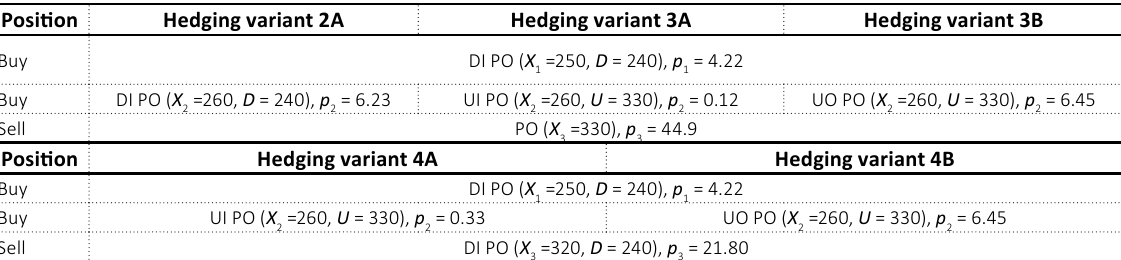
Source: Own design.